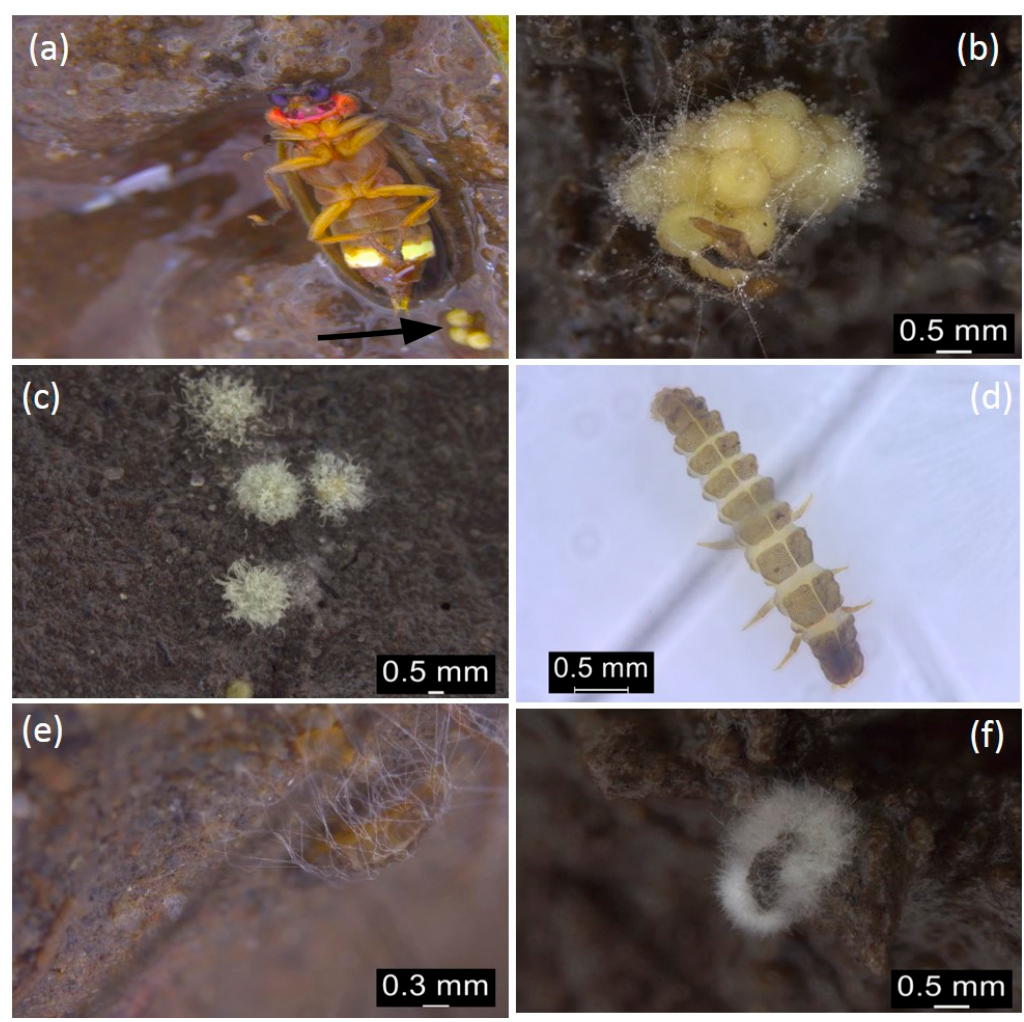
Figure 2. Pteroptyx bearni ’s eggs: ( a ) Female Pteroptyx bearni and its eggs indicated by arrow; ( b ) firefly’s eggs infected by fungus after three days since the first hyphae observed on the surface; ( c ) microfungi infection on the eggs after seven days since the first hyphae was observed. Pteroptyx bearni ’s larvae: ( d ) Pteroptyx bearni larva without infection; ( e ) larvae infected by fungus after three days since the larva become immobile and preparing for ecdysis; ( f ) The larva after ten days since the first hyphae was observed.